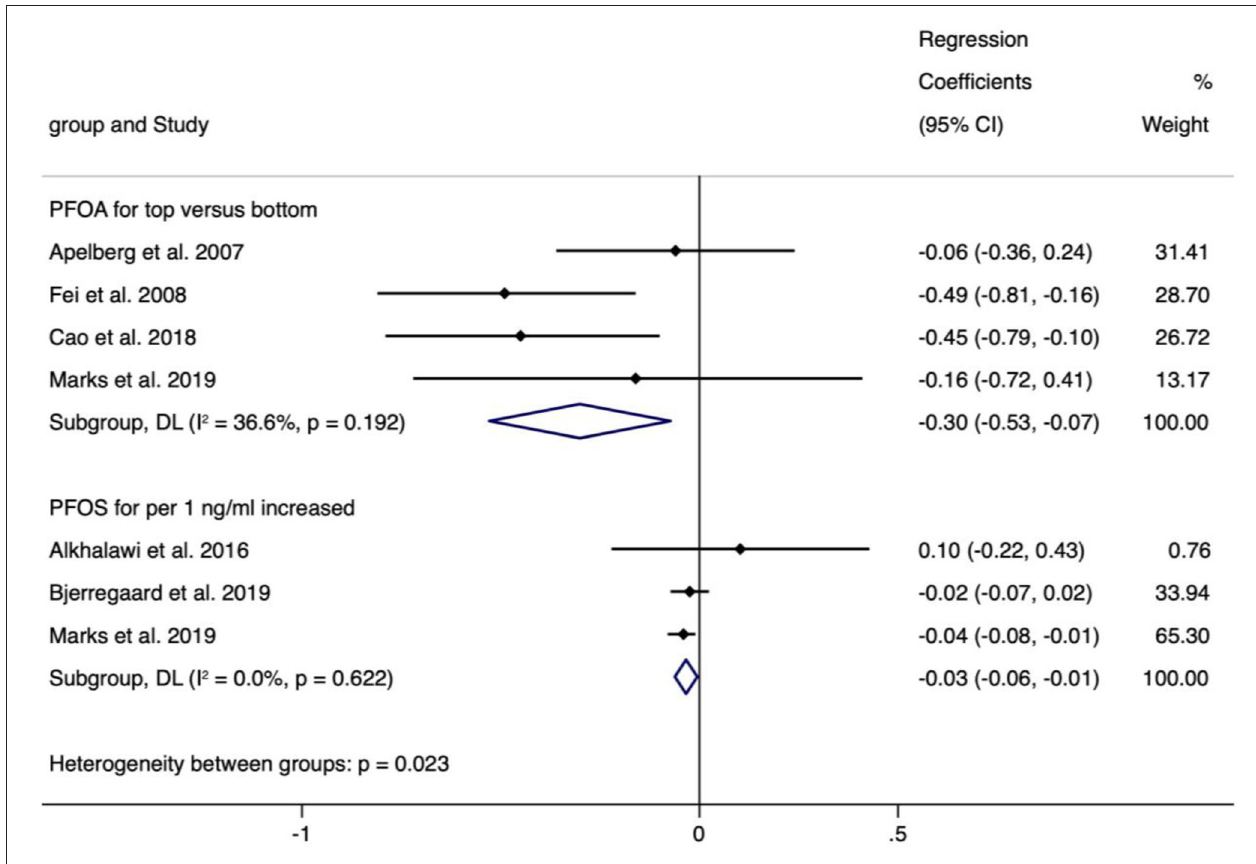
The meta-analyses indicated that only exposure to PFOS ( n = 2, − 0.355, 95% CI = − 0.702 to − 0.008 per 1 ng/ml increase) and PFOA ( n = 3, − 0.412, 95% CI = − 0.787 to − 0.037 per 1 ng/ml increase) showed statistically significant decrease in PI and no heterogeneity (I 2 = 0.0% and 0.0%), with regression coefficients varied from − 0.412 (PFOA, n = 2) to 0.100 (PFNA, n = 1 and PFDA, n = 1) ( Supplementary Table 12